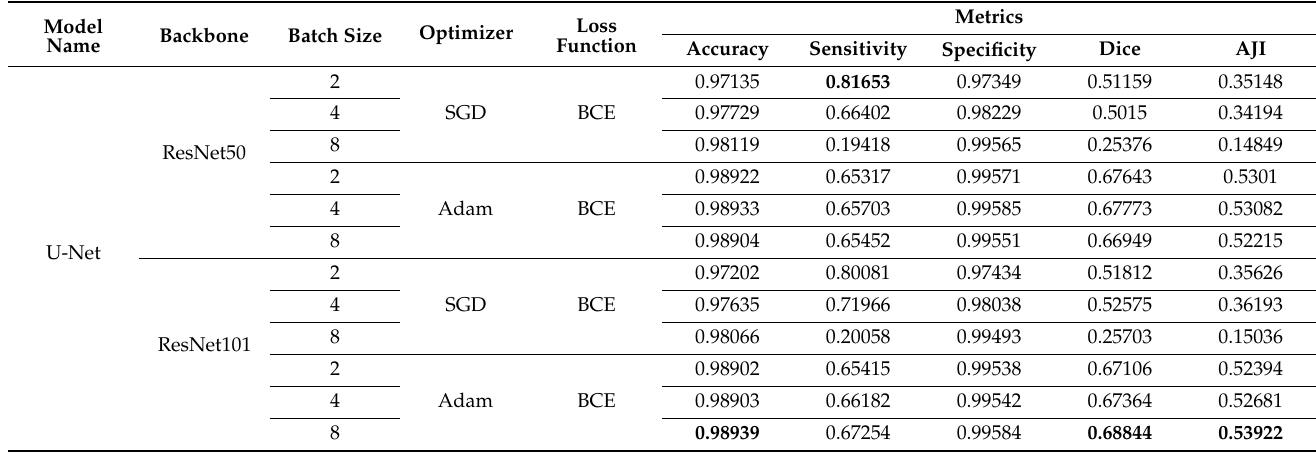
Figure 5. Visualization of two segmentation examples by the best U-Net and Detectron2 model from Table 1 for under- standing the details of the model performances. ( a ) Original test images (randomly selected from the unseen test set), ( b ) ground-truth annotated by pathologist (binary regions corresponding to the original images), ( c ) predicted image by the Detectron2 model, individual image prediction with ACC, SEN, Dice, and AJI scores are presented on the top of the image (inside the blue box), the red arrow indicates the false positive and ( d ) predicted image by the U-Net model, individual image prediction with ACC, SEN, Dice, and AJI scores are presented on the top of the image (inside the blue box), yellow arrow indicates the model can segment the boundary connected cell. Table 1. A performance comparison between the U-Net and Detectron2 on the test data set, using different combinations of backbone, batch size, optimizer and loss functions (bold represent the best